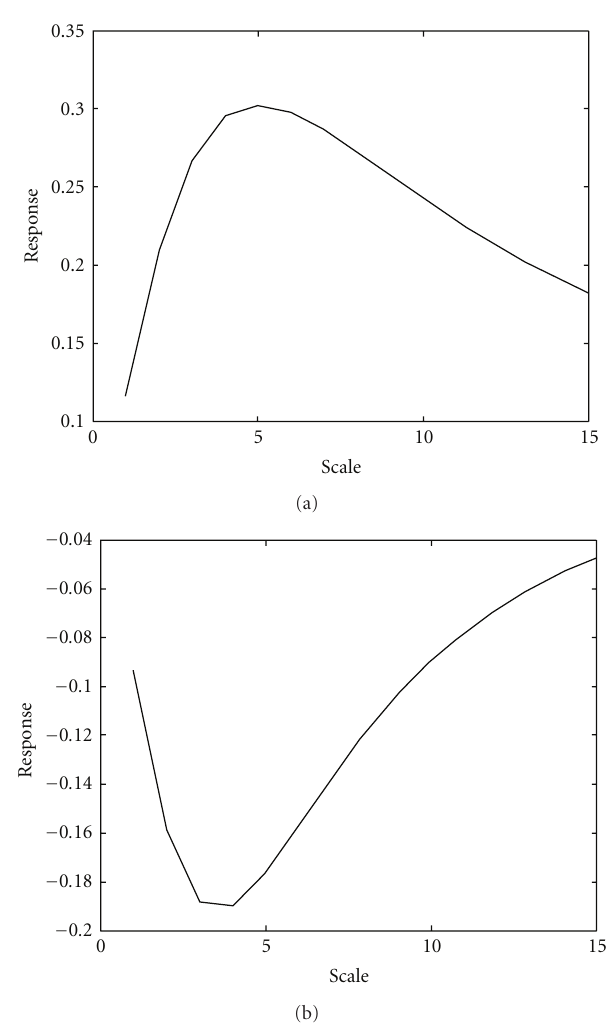
Figure 4: Responses to convolution of the original image with the first- (a) and second- (b) order Gaussian derivatives. Original image has an object with Gaussian intensity profile of kernel size σ obj = 5. Gaussian derivative probes scanned over kernel width range σ probe =